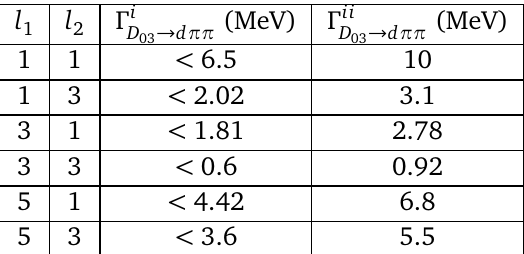
Table 1: The partial width Γ at different values of the orbital angular mo- D 03 → d ππ menta l and l (see text for 1 2